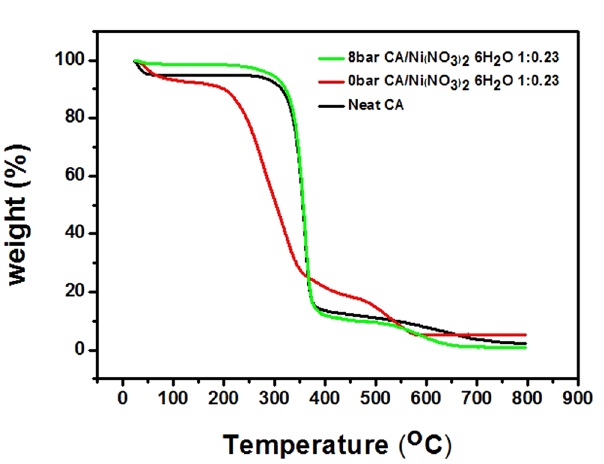
Figure 7. Concentration profiles of CA, EC, and DEC of the initial (0 ns) and final (5 ns) states of the layered system.